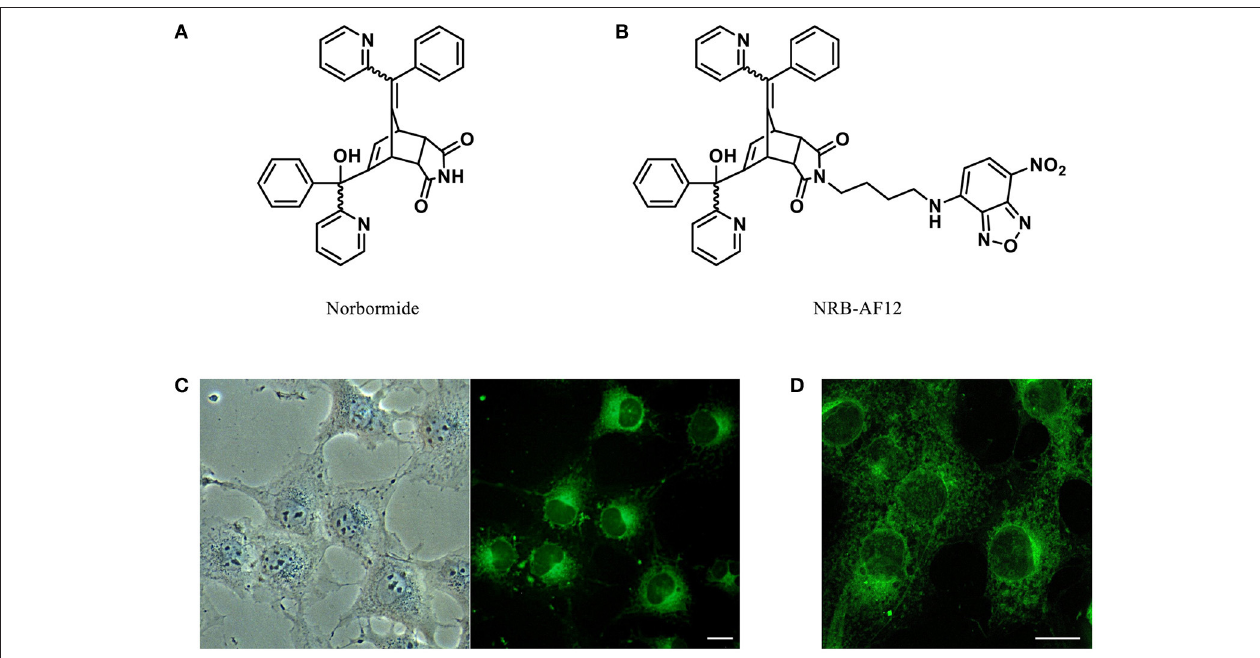
FIGURE 1 | Chemical structures of (A) Norbormide and (B) its fluorescent derivative NRB-AF12. (C) Live cell imaging of LX2 hepatic stellate cells fluorescently labeled with 500 η M NRB-AF12 for 30 min. Magnification 40x; scale bar 20 µ m. (D) LX2 cells stained with NRB-AF12 were fixed and imaged by confocal microscopy. Magnification 60x; scale bar 20 µ